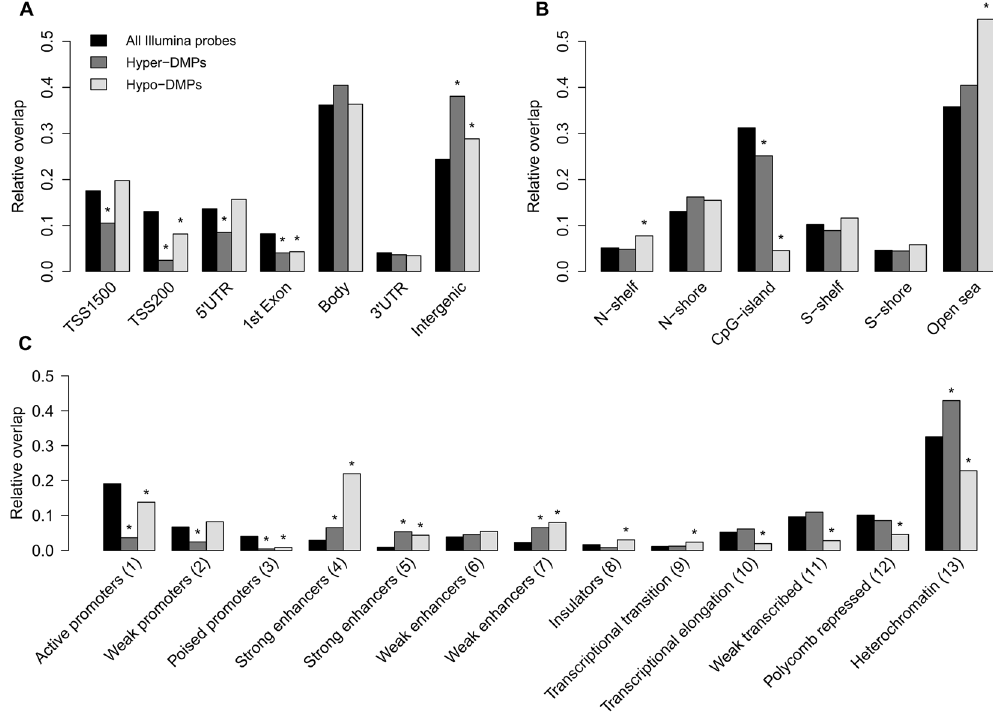
Figure 3. Genomic distribution of sig-DMPs based on ( A ) gene regions, ( B ) CpG-island regions and ( C ) chromatin segmentation states (based on GM12878 cell type data). Significant enrichment or depletion of sig- DMPs (P-value < 0.05), determined by the Fisher’s exact test, are marked by an